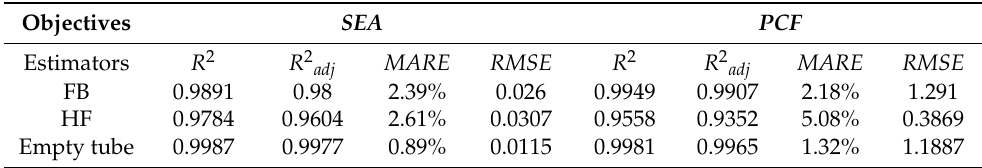
Table 2. Accuracy of the prediction model.